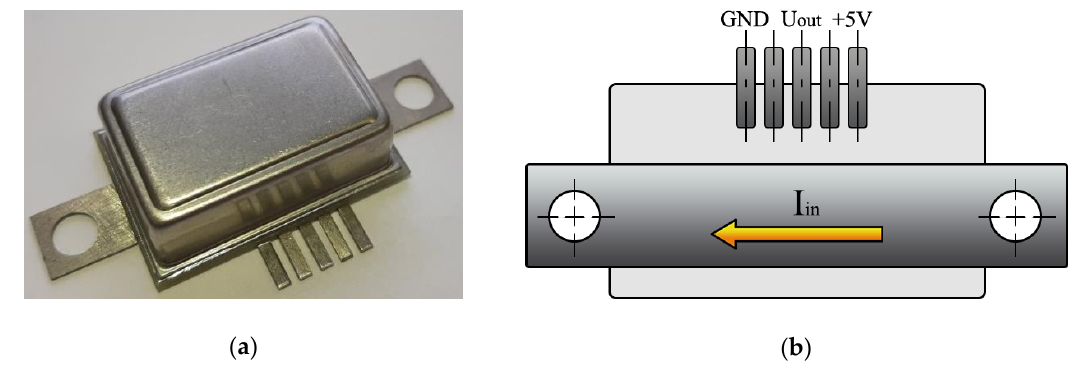
Figure 8. The block scheme of the ME current sensor.